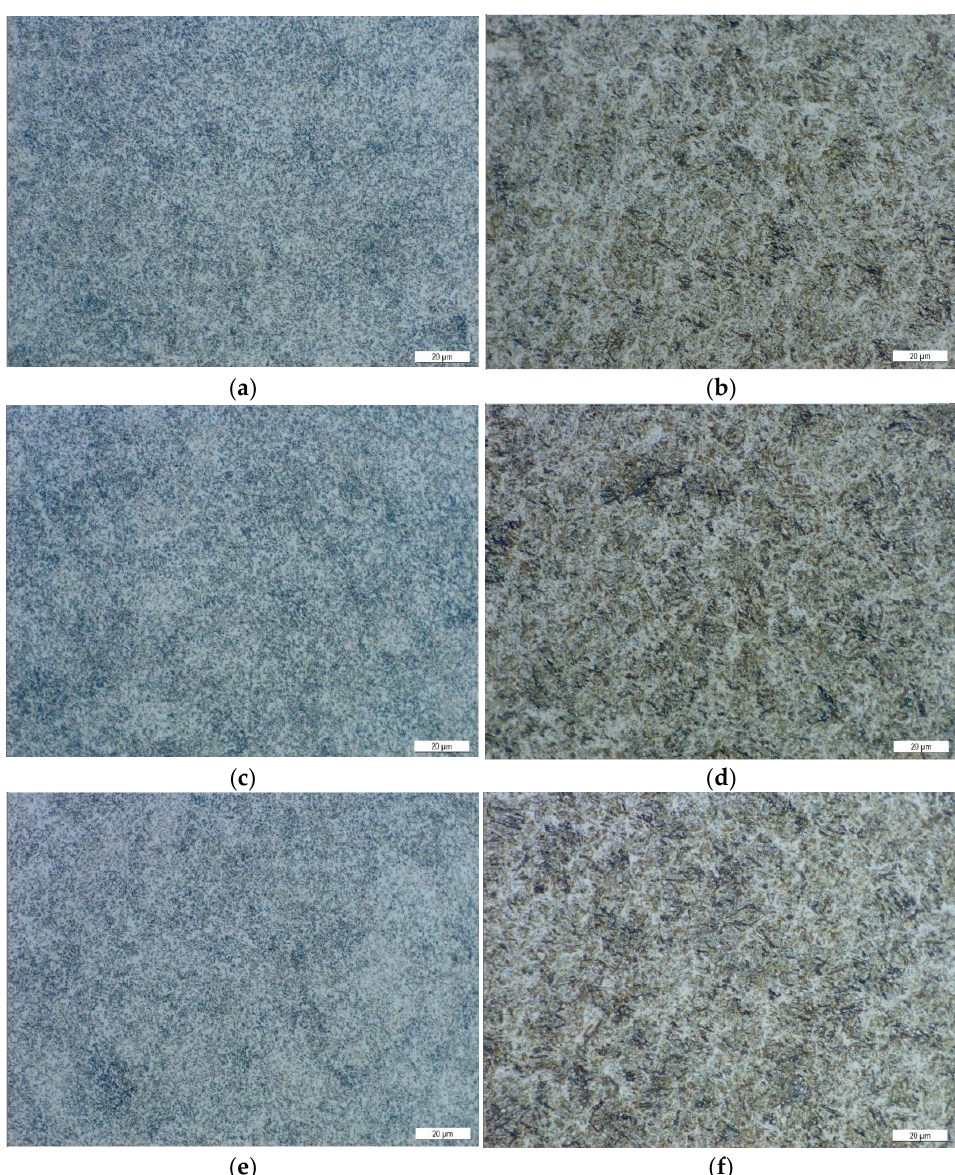
Figure 2. Microstructure of the surface layer before and after quenching. ( a ) Organization of inner surface layer before quenching; ( b ) organization of inner surface layer after quenching; ( c ) organization of neutral layer before quenching; ( d ) organization of neutral layer after quenching; ( e ) organization of outer surface layer before quenching; ( f ) organization of outer surface layer after quenching.